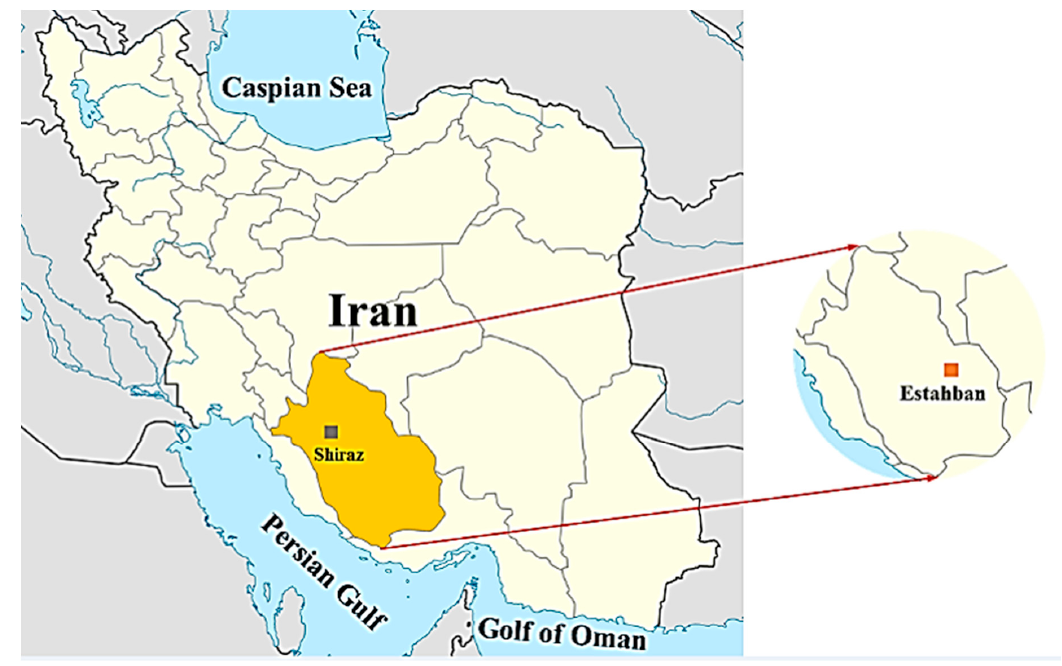
Figure 2. The topographic map of